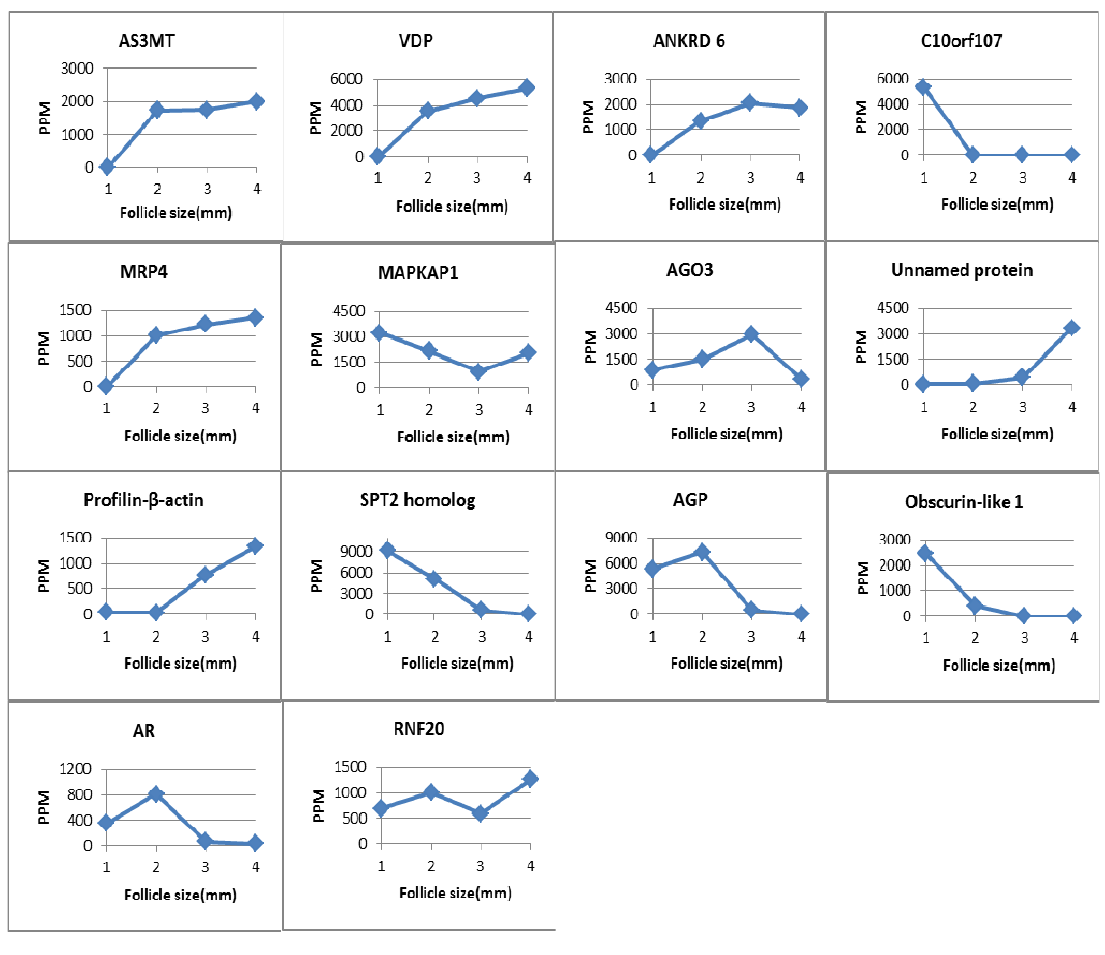
Figure 2. The contents of the differentially expressed proteins in the four ovarian follicle groups (1,2,3,4) correspond to follicle size: 0–2, 2–4, 4–6, and >6 mm, respectively. PPM calculated by PDQuest